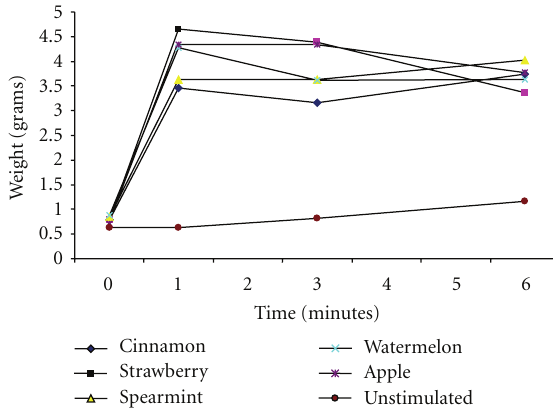
Figure 1: The changes in mean salivary flow rate (SFR) over 6 min after the start of one pellet of cinnamon-, strawberry-, spearmint-, watermelon-, or apple-flavored chewing gum compared with un- stimulated SFR. The mean (SD) of SFR before and 0-1, 1–3 and 3–6 min after the start of di ff erent flavored chewing gums is shown.